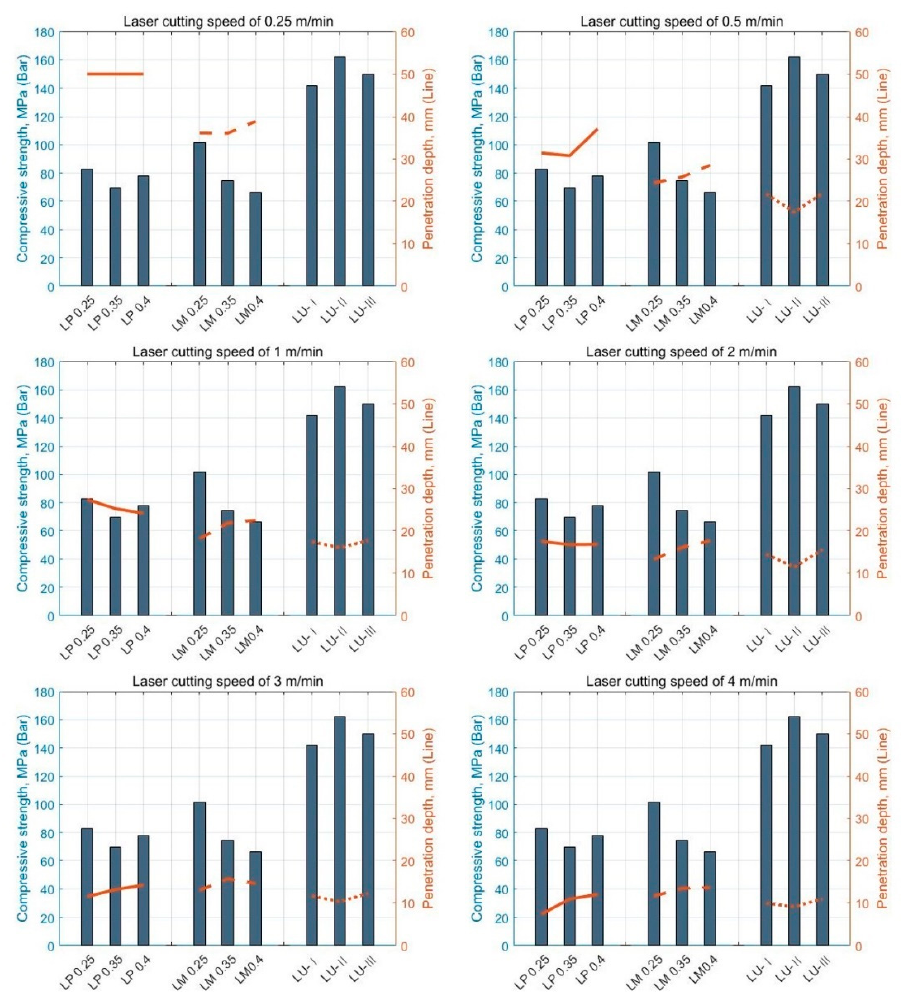
Figure 9. Relationship between compressive strength and penetration depth according to laser cutting speed.